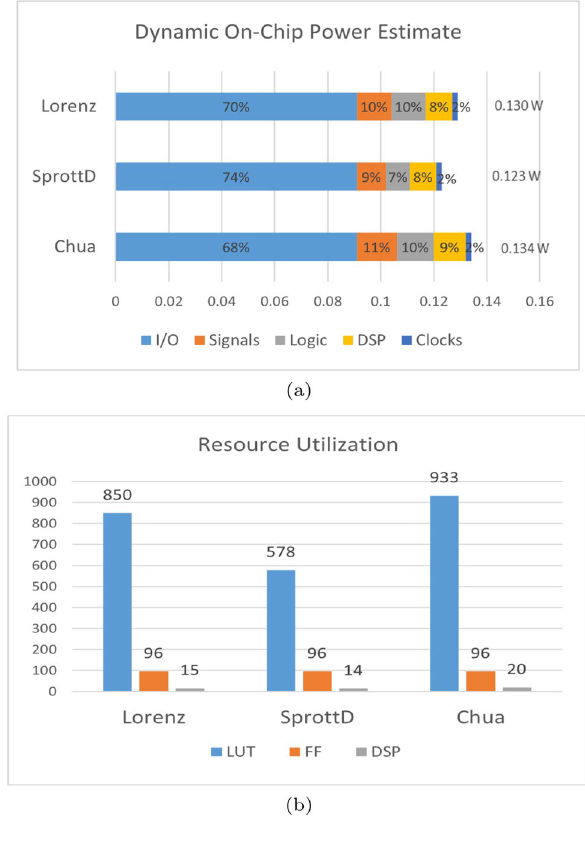
Fig. 13 Comparison of chaotic equation for a On-chip power estimate, b Resource utiliza- tion